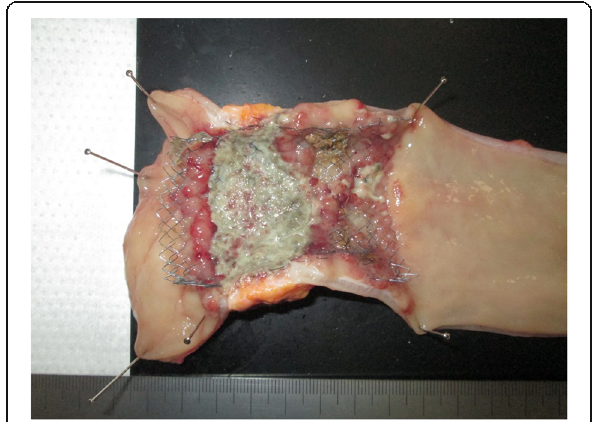
Fig. 2 Macroscopic findings. Gross examination of the resected rectal specimen with the stent showed smooth and mild stenosis with growth of fibrous tissue